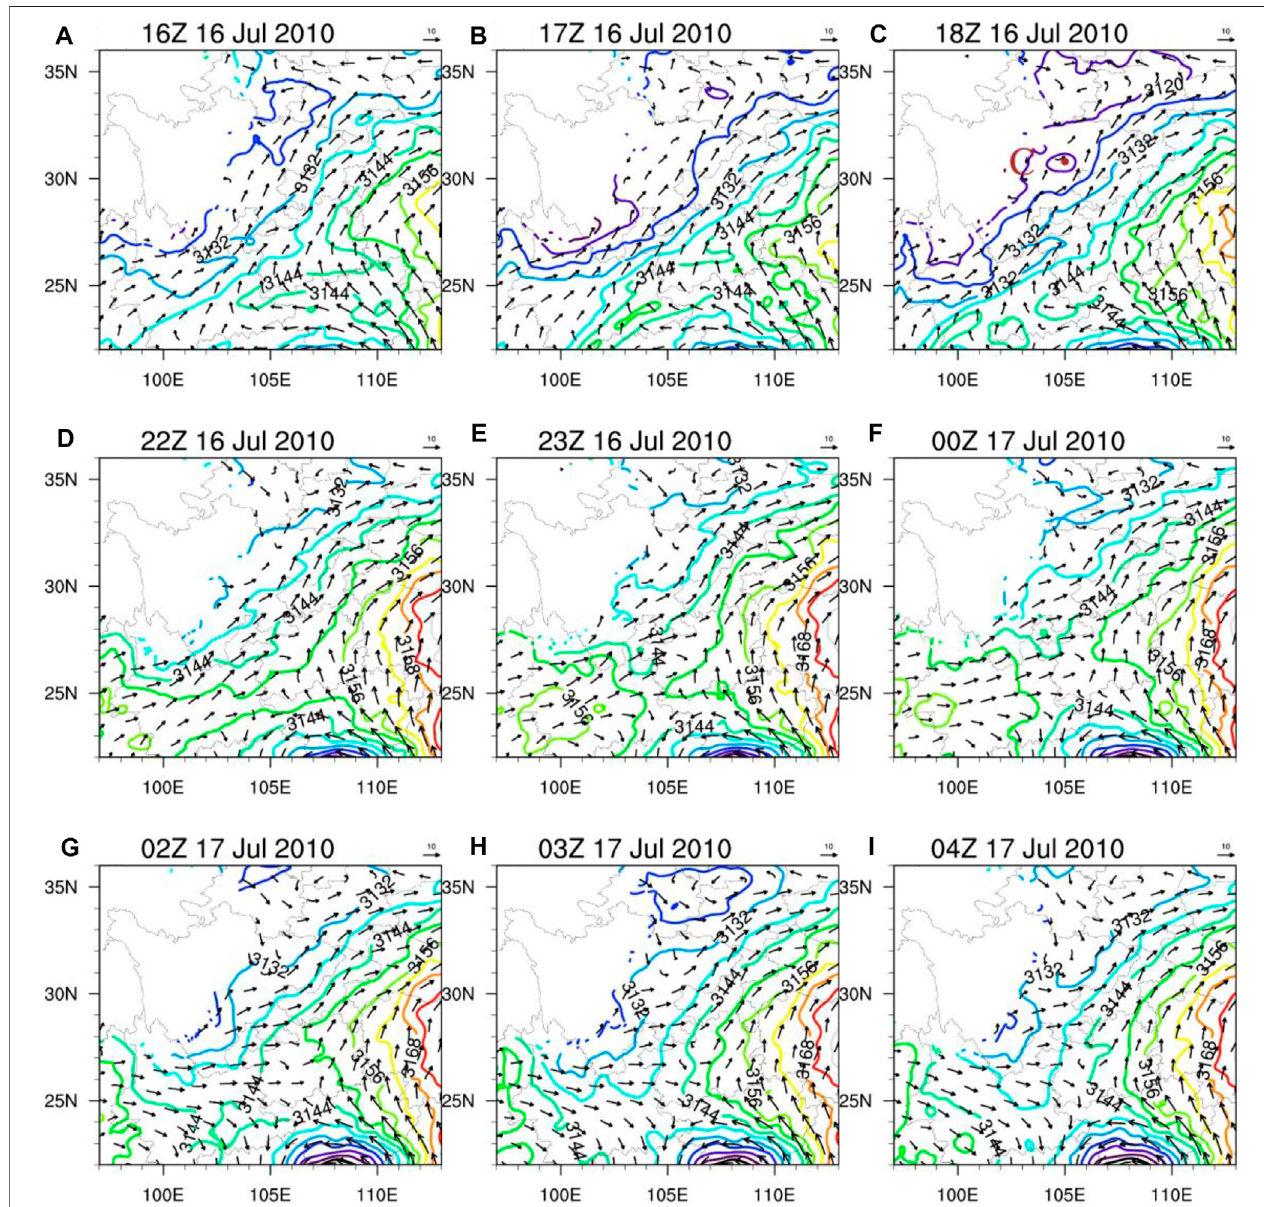
FIGURE 11 | The 700 hPa geopotential height (gpm, contours) and wind fi eld (m s − 1 , arrows) for the NOLH experiment at (A) 16:00 UTC July 16, (B) 17:00 UTC July 16, (C) 18:00 UTC July 16, (D) 22:00 UTC July 16 (E) 23:00 UTC July 16, (F) 00:00 UTC July 17, (G) 02:00 UTC July 17, (H) 03:00 UTC July 17, and (i) 04:00 UTC July